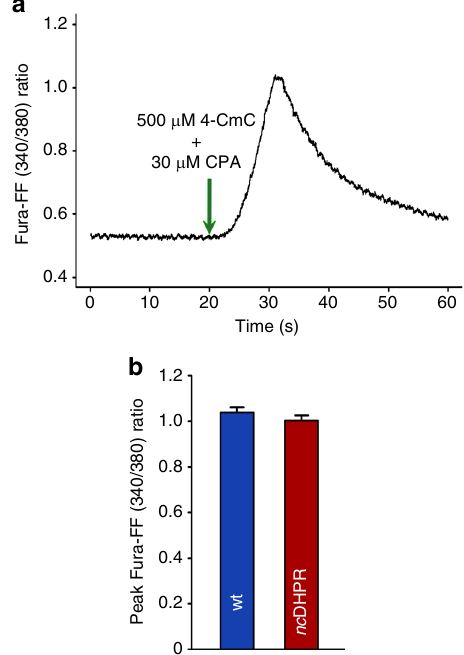
Fig. 3 Absence of DHPR-mediated Ca 2+ in fl ux has no impact on SR Ca 2+ store content. a Representative trace of SR Ca 2+ release in intact interosseous muscle fi bres triggered by application (green arrow) of 500 µ M of RyR agonist 4-CmC in the presence of 30 µ M of SERCA blocker CPA. The resulting Ca 2+ signals were measured with the low af fi nity indicator Fura-FF-AM to avoid dye saturation during Ca 2+ release stimulation. b Comparison of 4-CmC-induced Ca 2+ signals, measured as peak fl uorescence ratio of Fura-FF (340/380) showed no signi fi cant difference ( P > 0.05) between nc DHPR (1.0 ± 0.02; n = 53) and wt muscle fi bres (1.04 ± 0.02; n = 48), indicating identical SR Ca 2+ store fi lling. Bars represent mean ± s.e.m.; P determined by unpaired Student ’ s t -test